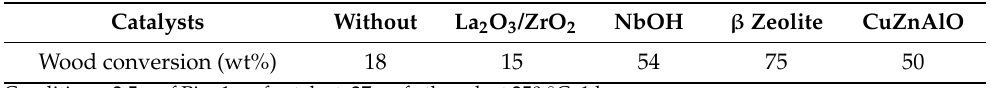
Table 1. Pin conversions (wt%) obtained in SC ethanol in the presence of various catalysts. Catalysts Without La 2 O 3 /ZrO 2 NbOH β Zeolite CuZnAlO Wood conversion (wt%) 18 15 54